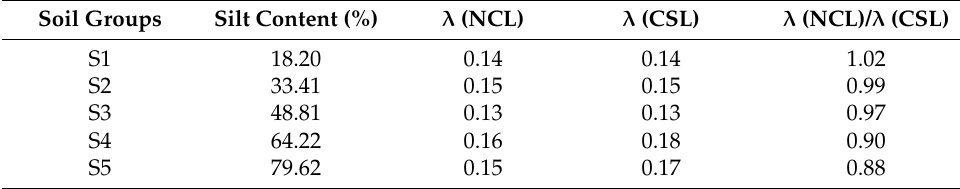
Table 5. Summary of CSL and NCL